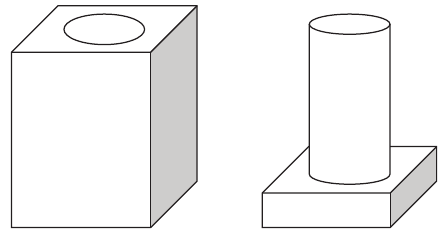
Figure 10: Experimental workpiece.